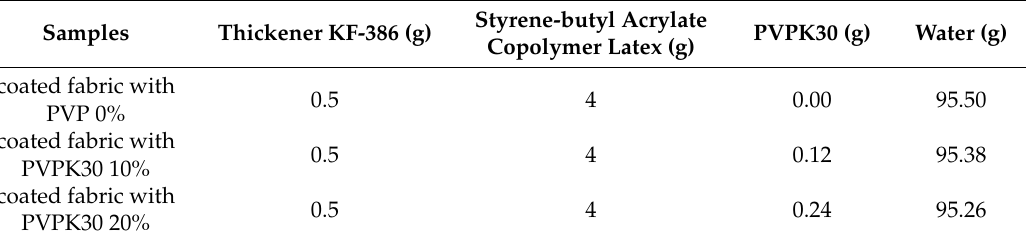
Table 2. The formula of coating